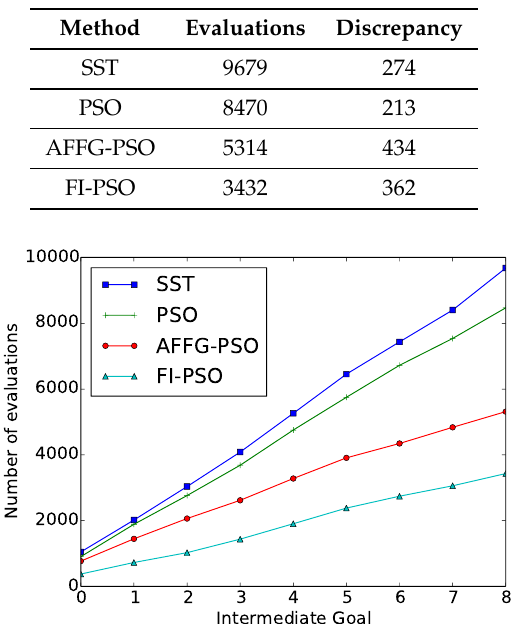
Figure 4. “Wax” Evolutionary Approximation results: Number of cumulative evaluations for each intermediate goal.